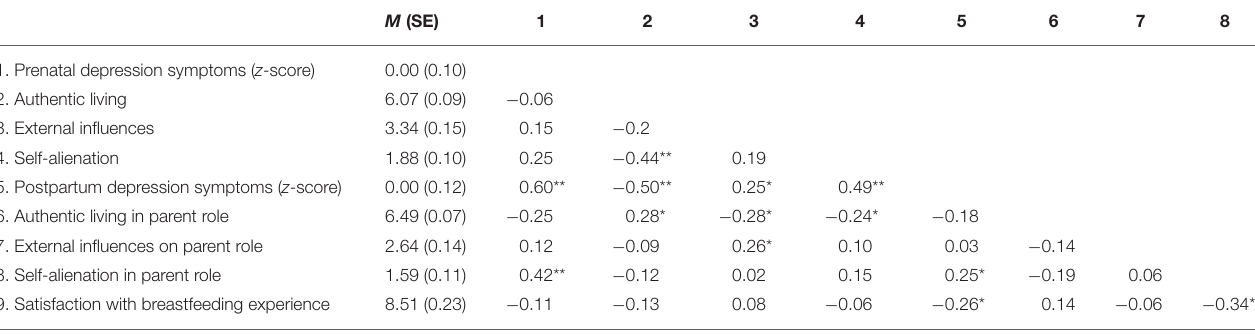
TABLE 2 | Descriptive statistics and bivariate correlations for primary variables and covariates.